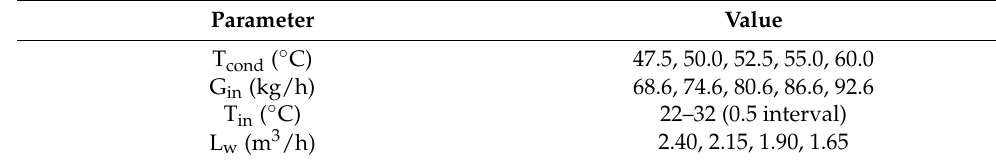
Table 7. Operating conditions during experiments in the study of Chen et al.